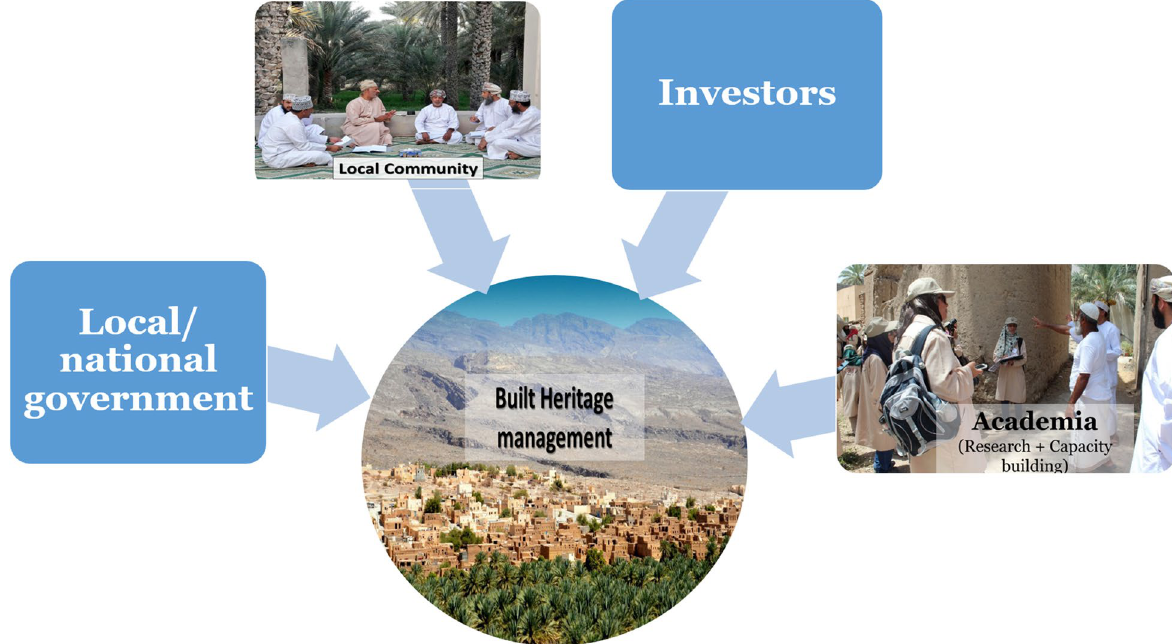
Fig. 11 The four main actors involved in vernacular heritage renovation and reuse (Source: the